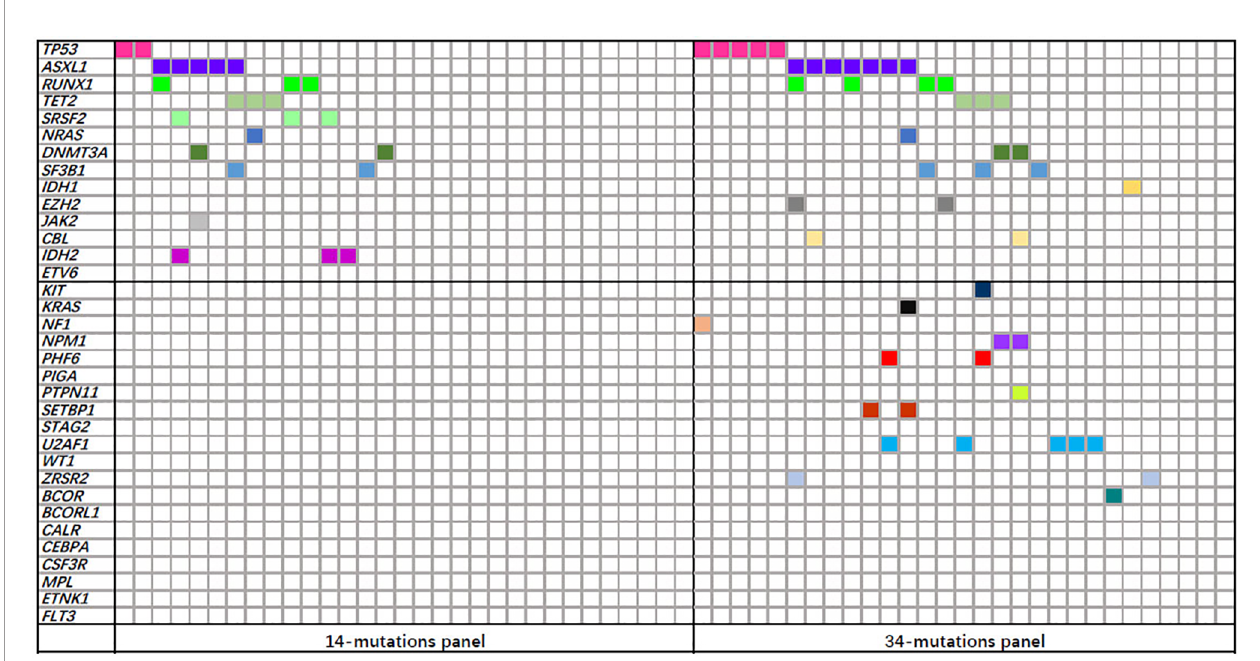
FIGURE 1 | Mutation spectrum of 14 or 34 common genes in 60 myelodysplastic syndrome (MDS) patients. Each column represents an individual patient sample, and each colored cell represents a mutation of the